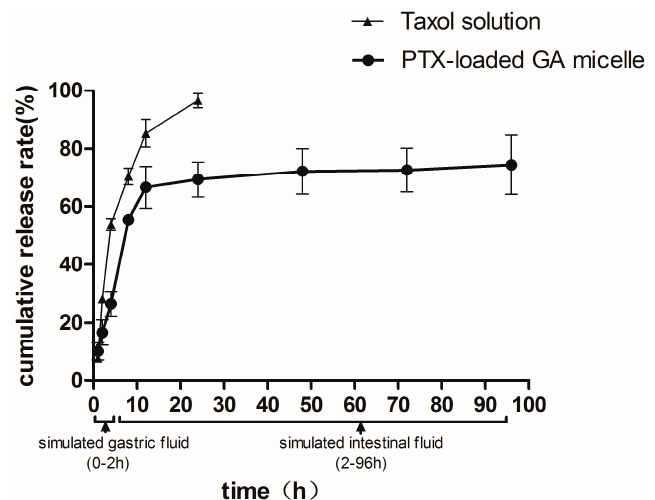
Figure 4. The cumulative release rates of paclitaxel from PTX-loaded GA micelles and Taxol ® (Cremophor EL-based formulation) as a function of time in simulated gastric fluid (0–2 h) and in simulated intestinal fluid (2–96 h) at 37 °C. Data were presented as mean ± S.D. ( n = 3).